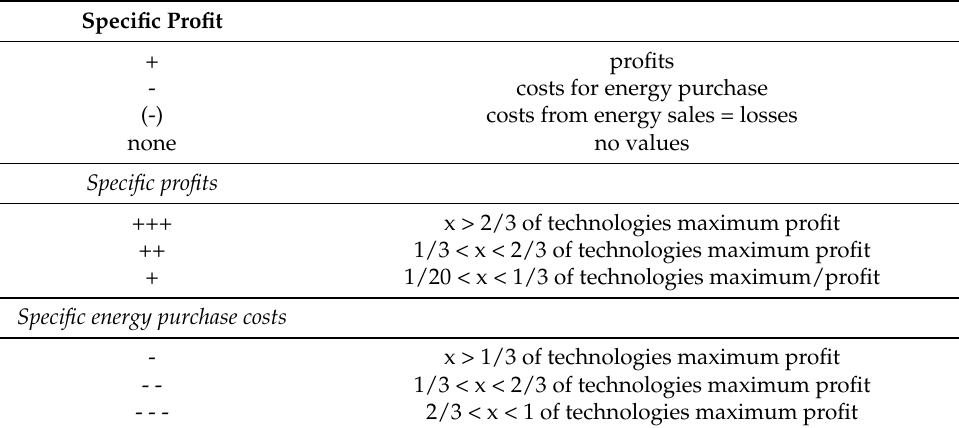
Table 16. Legend for the